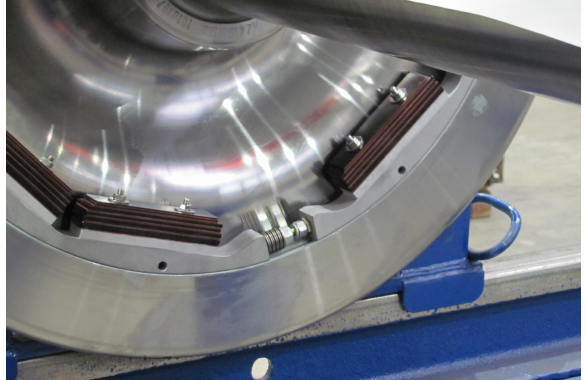
Figure 4. Railway wheel absorber (VICON RASA RSI, Schrey & Veit GmbH, Sprendlingen, Germany, reprinted with permission from Ref. [12], Copyright 2019, Schrey &Veit) comprising a stack of alternating metal and plastic plates as a longitudinal waveguide absorber. Tests proved a reduction in the noise level LAeq, Tp (ISO 3095) by about 4 dB..